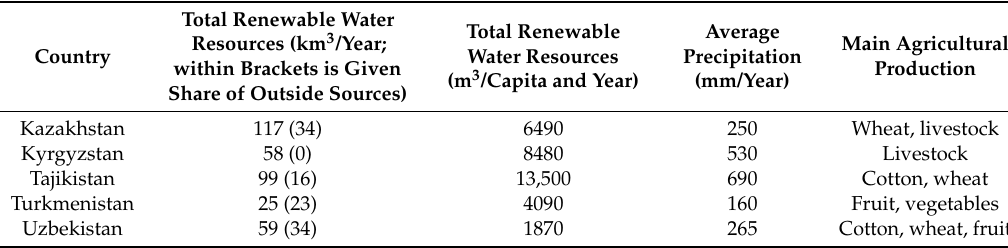
Table 1. Totally renewable water resources in Central Asian countries (surface and groundwater, after